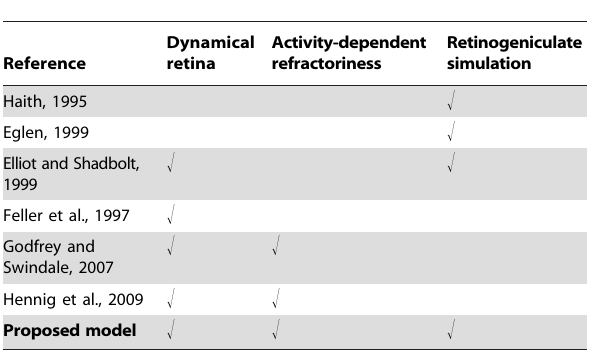
Table 2. Comparision of retinogeniculate models.